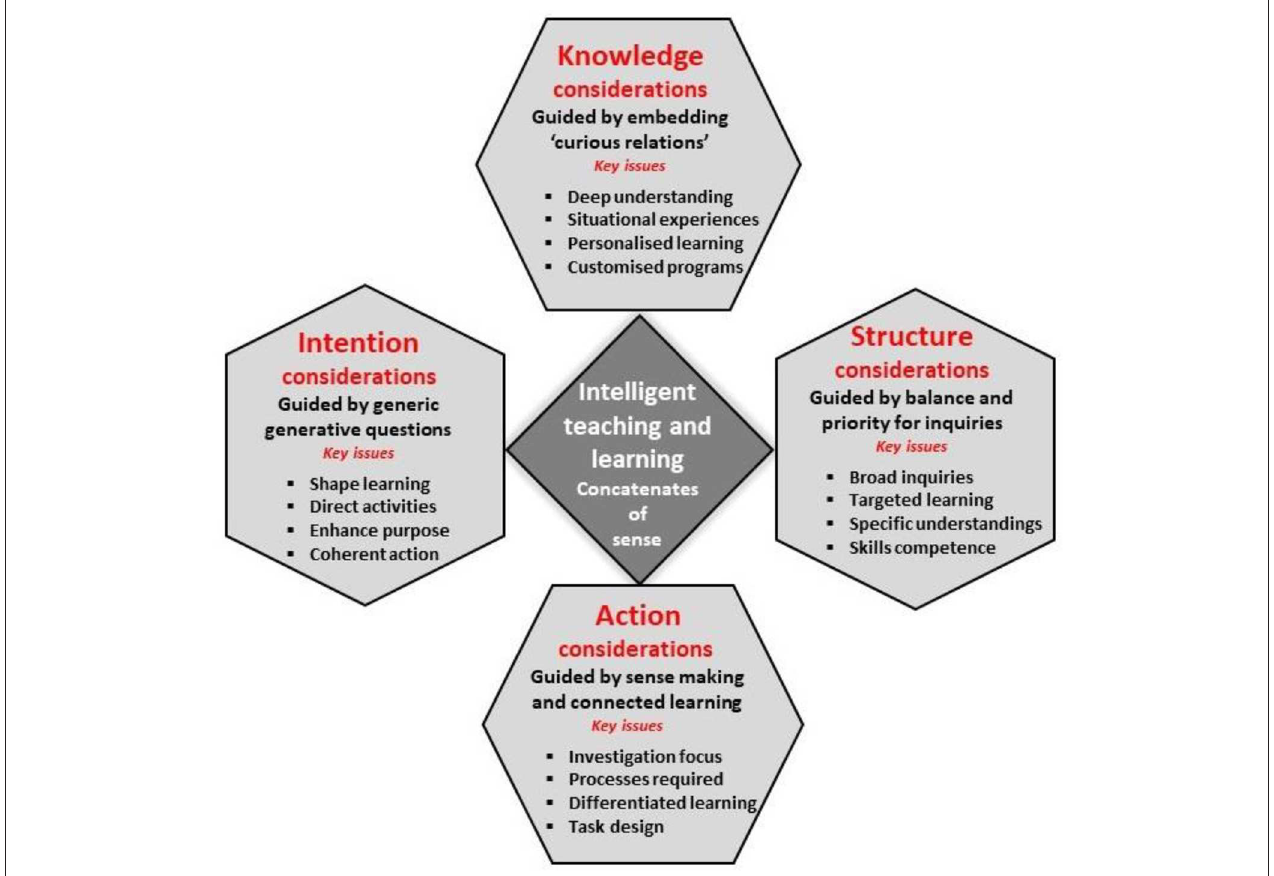
FIGURE 4 | Interrelated considerations. Reproduced with permission from Freestone and Mason